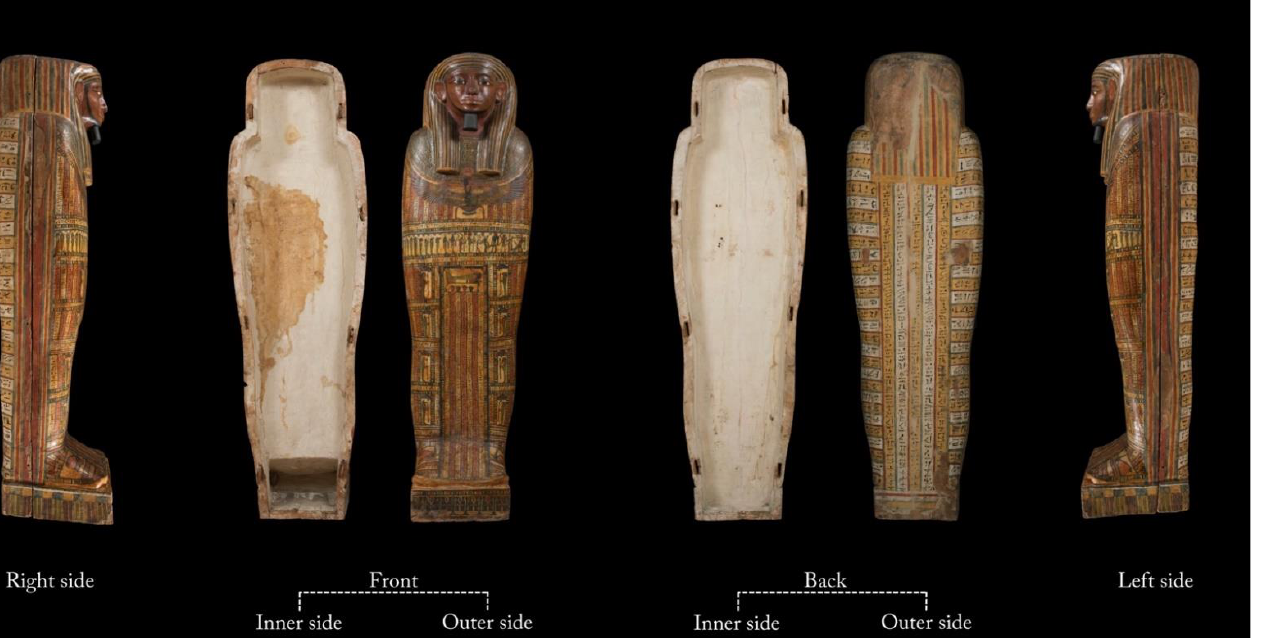
Figure 1. Inner and outer sides of Un-Montu’s coffin (Inv. MCABo EG1960). The head is covered by a tripartite wig: a very large rear band and two longer, nar- rower, and rounded lappets at the front sides with alternating yellow and blue parallel stripes. The face and its protruding ears are coloured in brown, the lips are coloured in red-brown, and the short beard on the chin is coloured in dark blue.